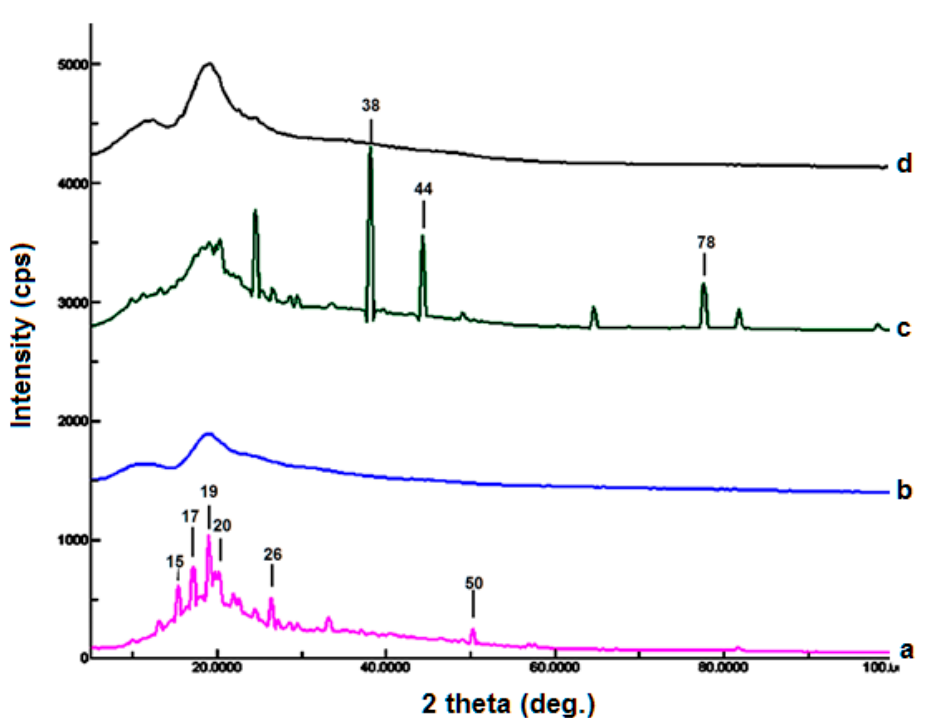
Figure 6. Powder X-ray of FLB (a), HP-BCD (b), physical mixture (c), complex (d).